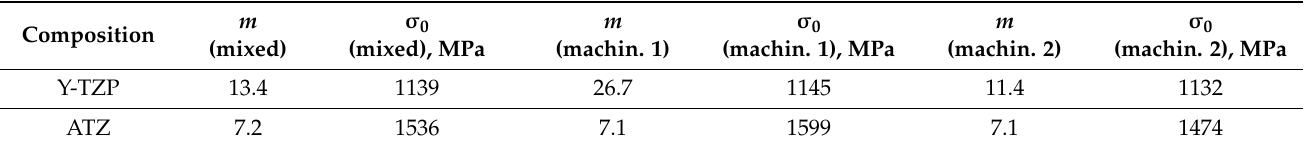
Table 3. Weibull parameters of yttria-stabilized zirconia (Y-TZP) and alumina-zirconia composite